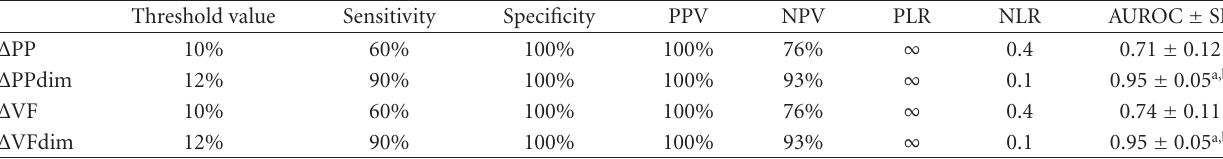
Table 5: Accuracy of hemodynamic parameters for predicting fluid